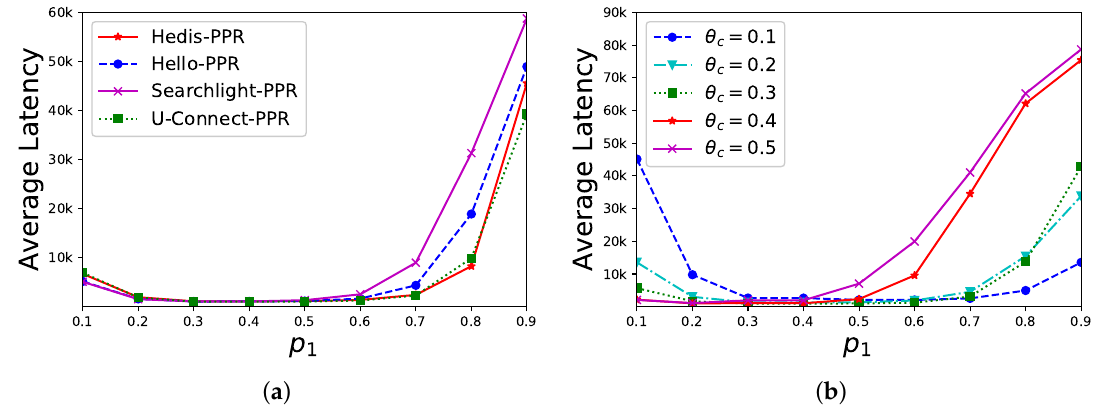
Figure 5. Sensitivity of p 1 in the PPR method. ( a ) θ c = 0.3; ( b ) U-Connect-PPR.